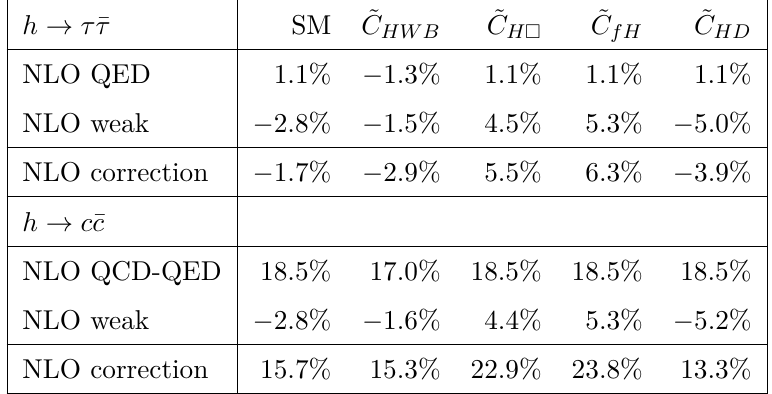
Table 2 . Size of NLO corrections to different terms in LO decay rate, split into QED(-QCD) and weak corrections for h → τ ¯ τ (top) and h → c ¯ c (bottom). See text for further explanation. Compared to LO, a total of 36 new Wilson coefficients appear at NLO in h → τ ¯ τ